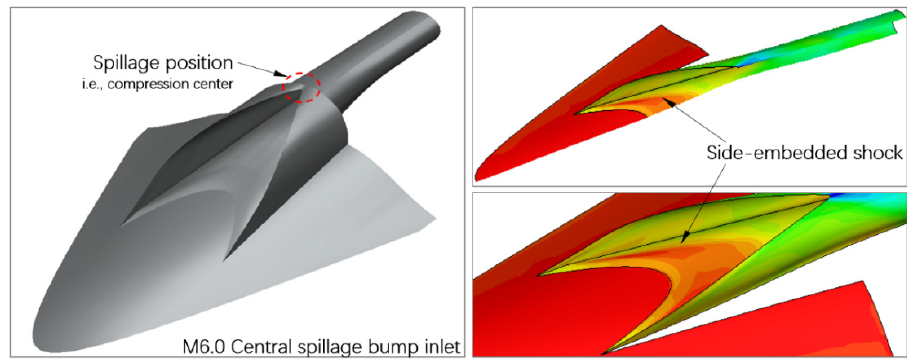
Figure 1. SES effects observed at the bottom surface of a central ‐ spillage bump inlet.